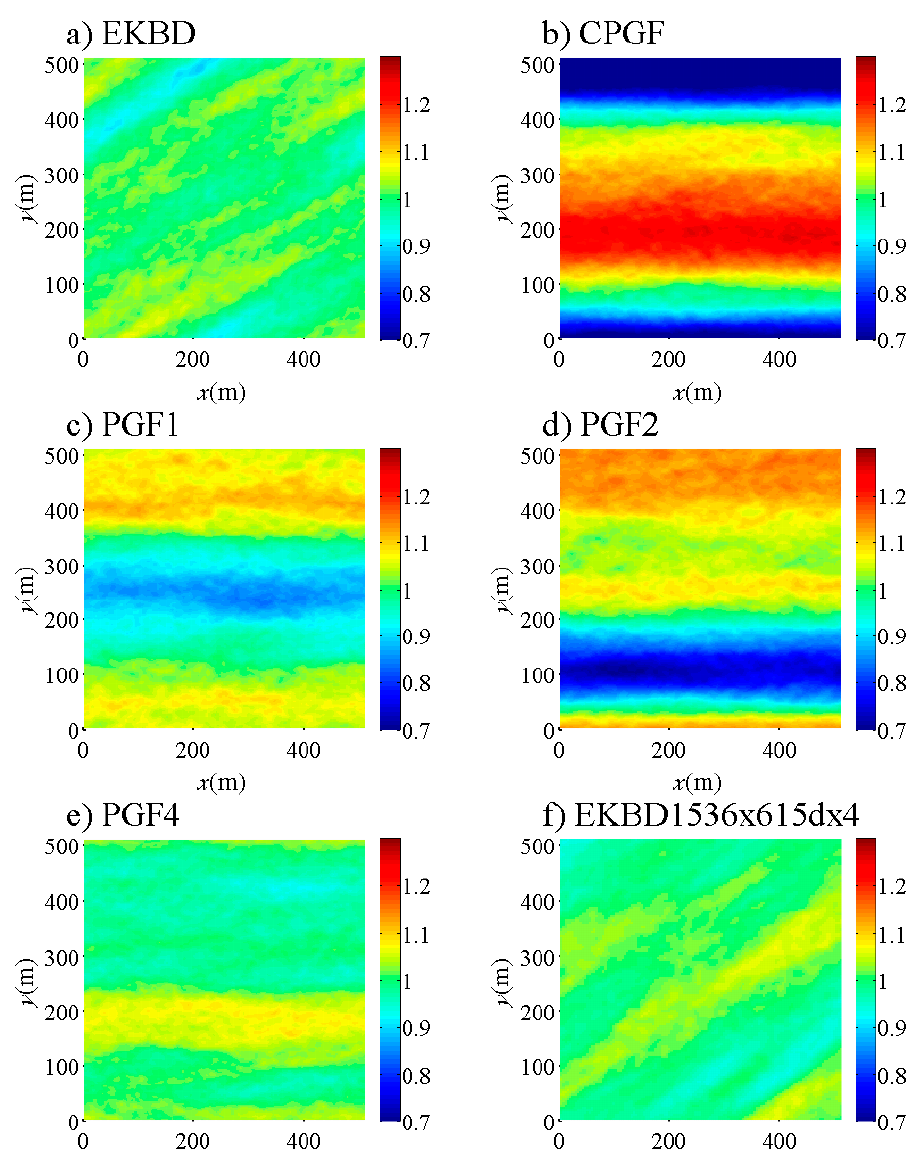
Figure 11. One-hour-averaged horizontal wind velocities on a horizontal plane at z = 53 m for the canopy-flow simulations (512 m × 512 m × 615 m): ( a ) EKBD, ( b ) CPGF, ( c ) PGF1, ( d ) PGF2, ( e ) PGF4, ( f ) subset of EKBD1536x615dx4 simulations, for reference. For each simulation, wind velocities are normalized by the mean wind velocity at z = 53 m.